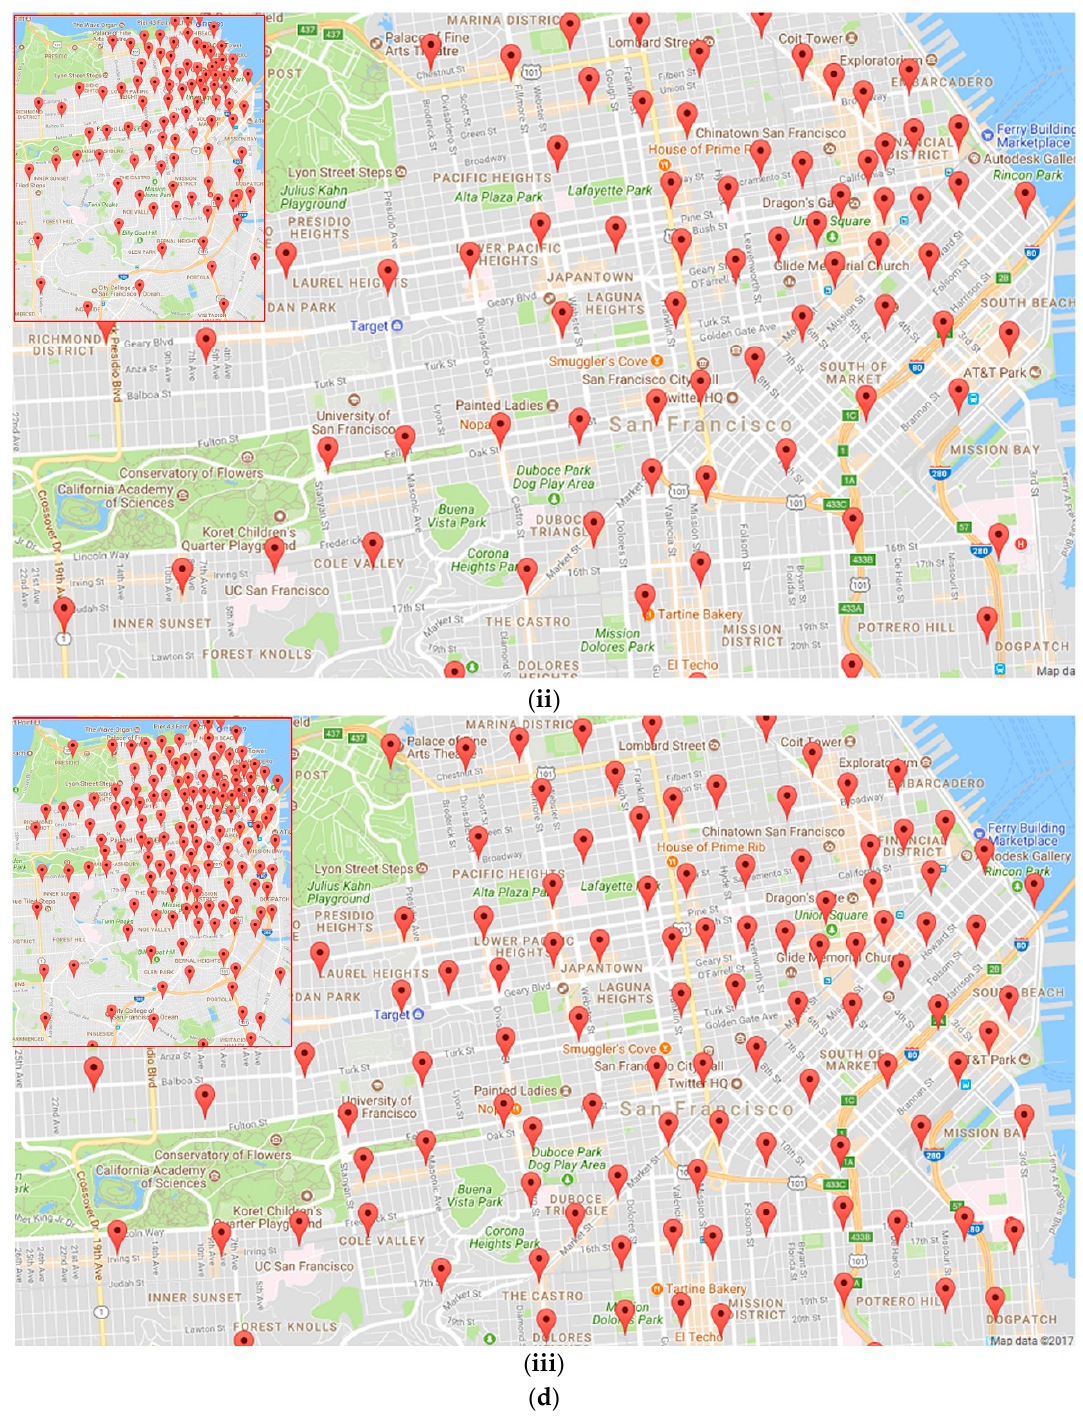
Figure 5. ( a ) The cluster centers are obtained from taxi GPS data sets from Aracaju (Brazil), using algorithms: ( i ) NoiseClust (126 clusters); ( ii ) GAK (100 clusters); and ( iii ) GenClust (119 clusters); ( b ) The cluster centers are obtained from taxi GPS data sets from Chongqing (China), using algorithms: ( i ) NoiseClust (138 clusters); ( ii ) GAK (100 clusters); and ( iii ) GenClust (138 clusters); ( c ) The cluster centers are obtained from taxi GPS data sets from Roma (Italy), using algorithms: ( i ) NoiseClust (138 clusters); ( ii ) GAK (100 clusters); and ( iii ) GenClust (134 clusters); ( d ) The cluster centers obtained from taxi GPS data sets from San Francisco (USA), using algorithms: ( i ) NoiseClust (146 clusters); ( ii ) GAK (100 clusters); and ( iii ) GenClust (147 clusters).